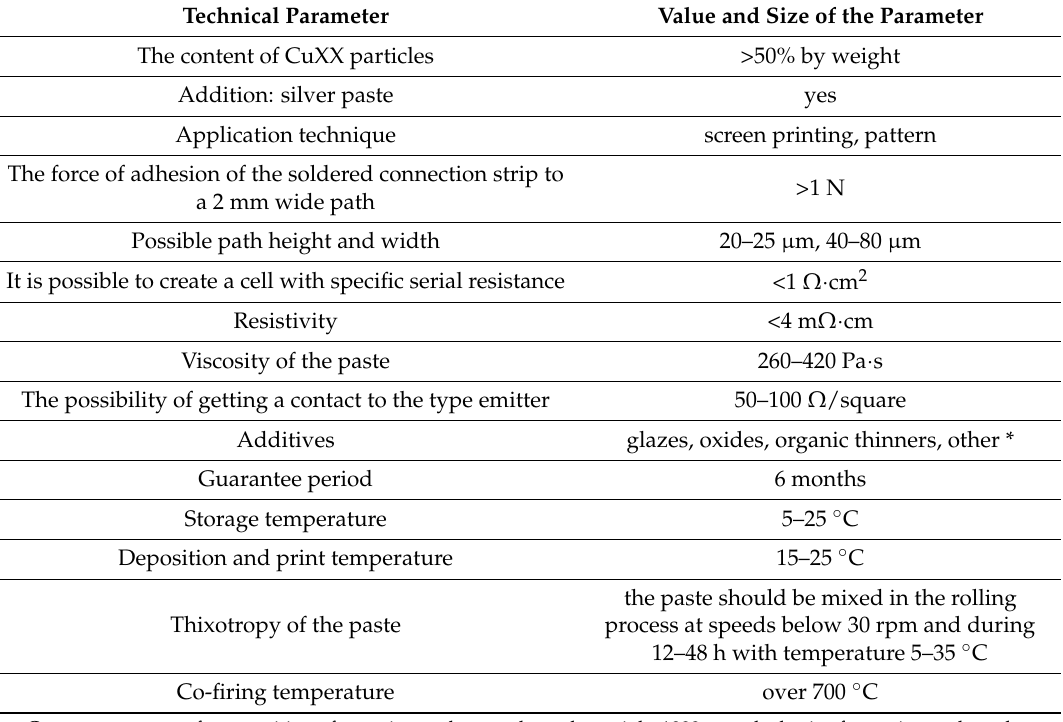
Table 2. Detailed properties of NPCuXX paste deposited onto metallic